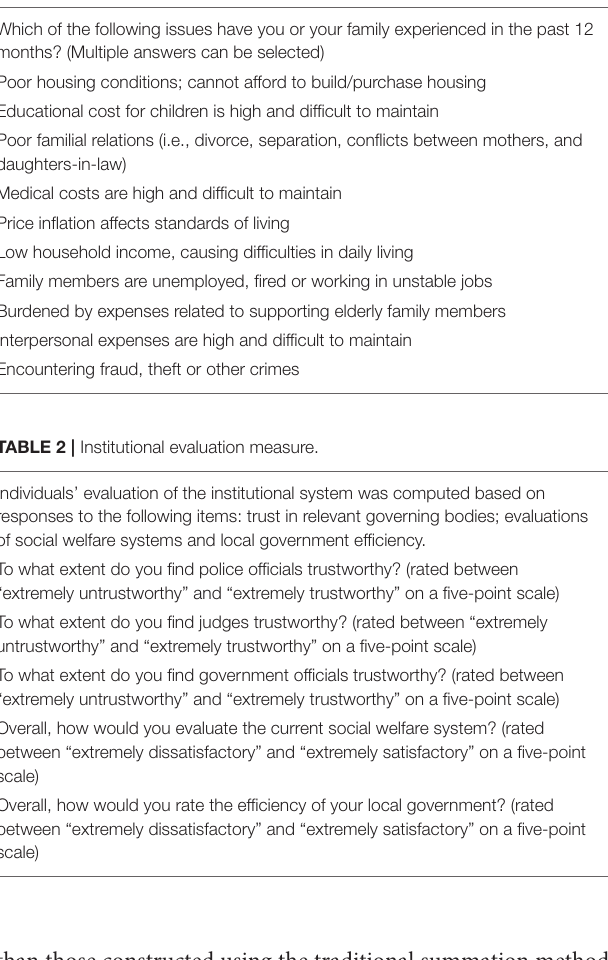
TABLE 3 | Demographic distribution of present sample across age